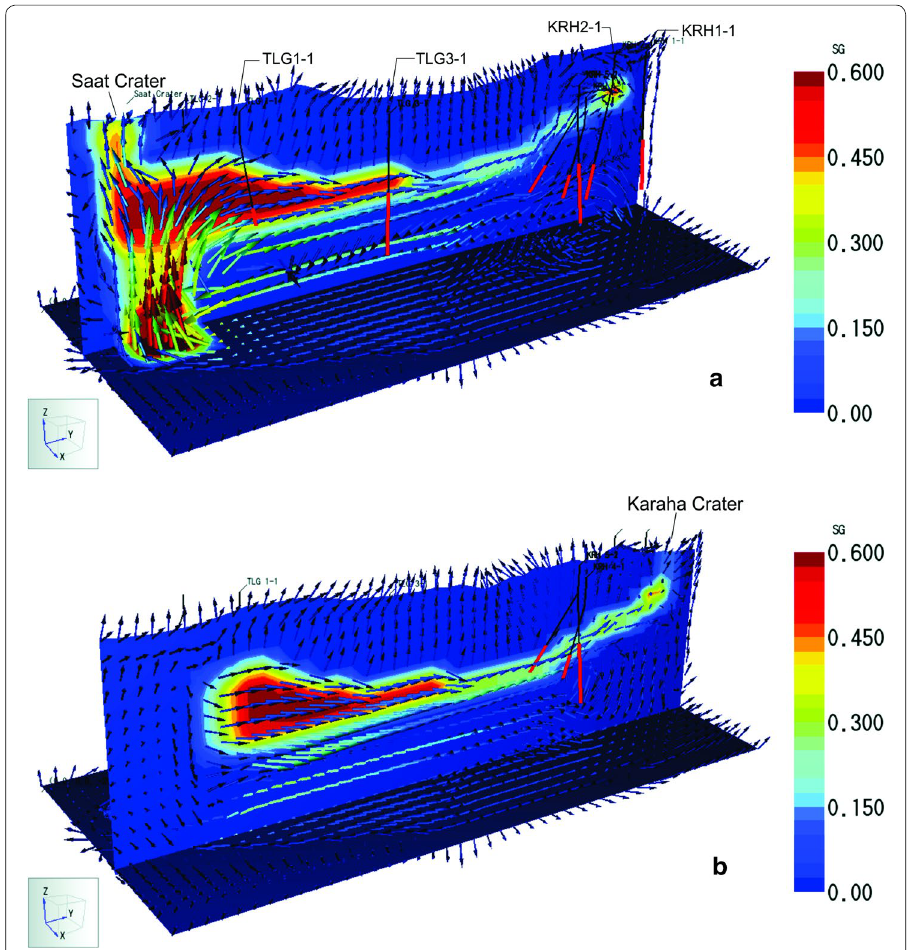
Fig. 11 An extending steam cap model slicing at X: a 1800 m b 2800